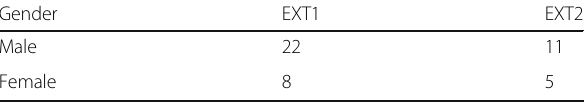
Table 3 The different EXT mutations according to gender